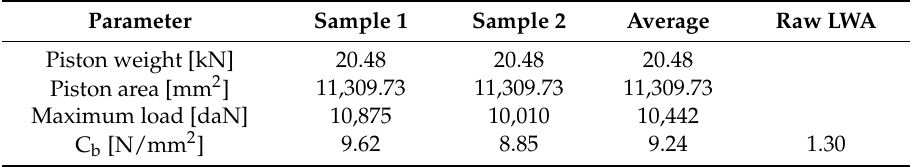
Table 4. ME-LWA crushing resistance.